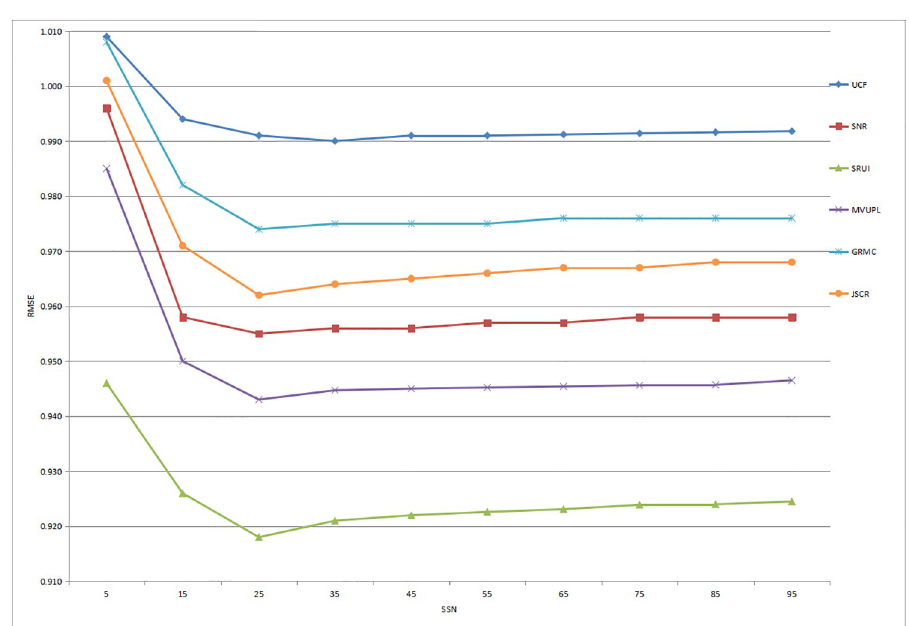
Fig 4. Prediction accuracy of all the comparison methods for different numbers of social similar neighbors based on the Douban dataset (RMSE).